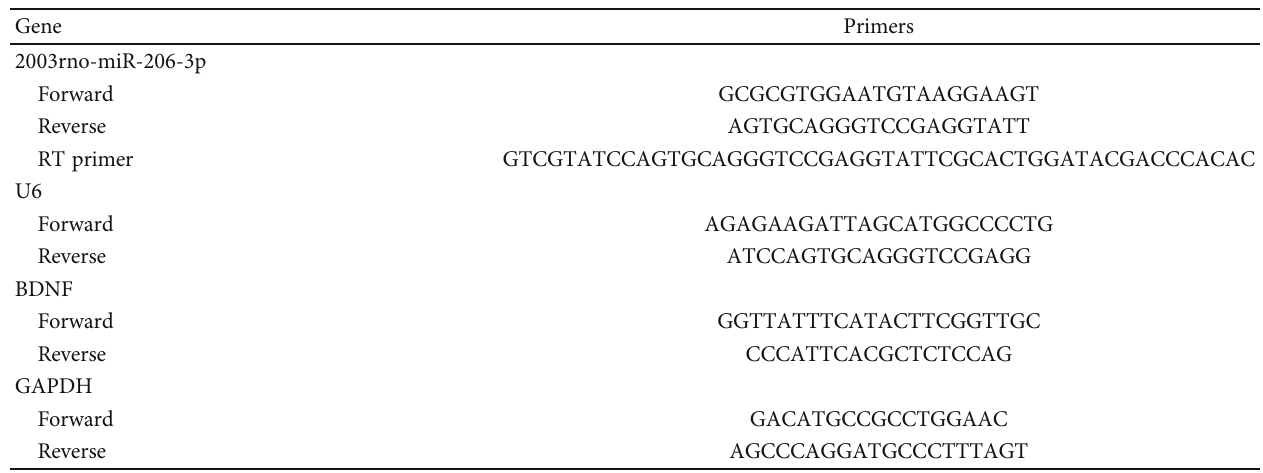
Table 1: Primers for rno-miR-206-3p and